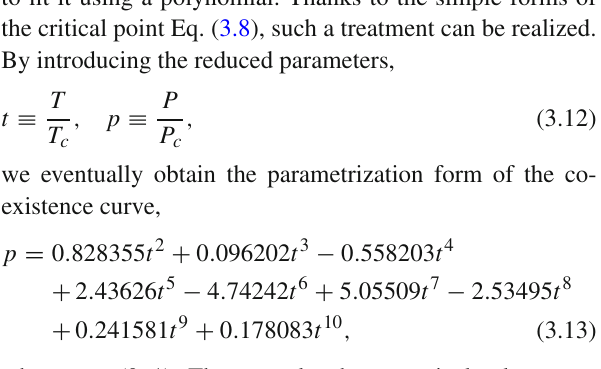
value of T = 0 . 11000, and for the isobar P ∗ = 0 . 01515, V 1 and V 2 correspond to r 1 = 1 . 94812 and r 2 = 2 . 40186, respectively. Corre- sponding to the middle diagram, the Gibbs free energy is depicted in the right diagram , showing the characteristic swallowtail